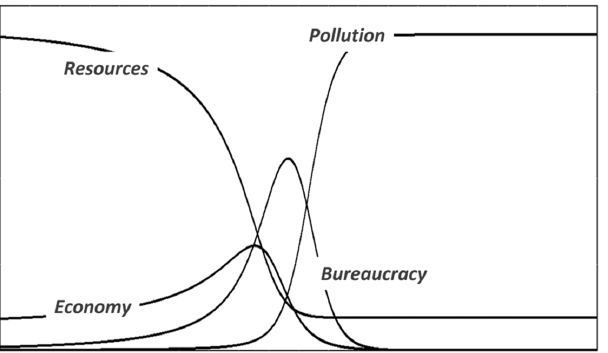
Figure 6. Example of the dissipative 3-stock system: the collapse of a complex society (from Bardi et al. [67]).